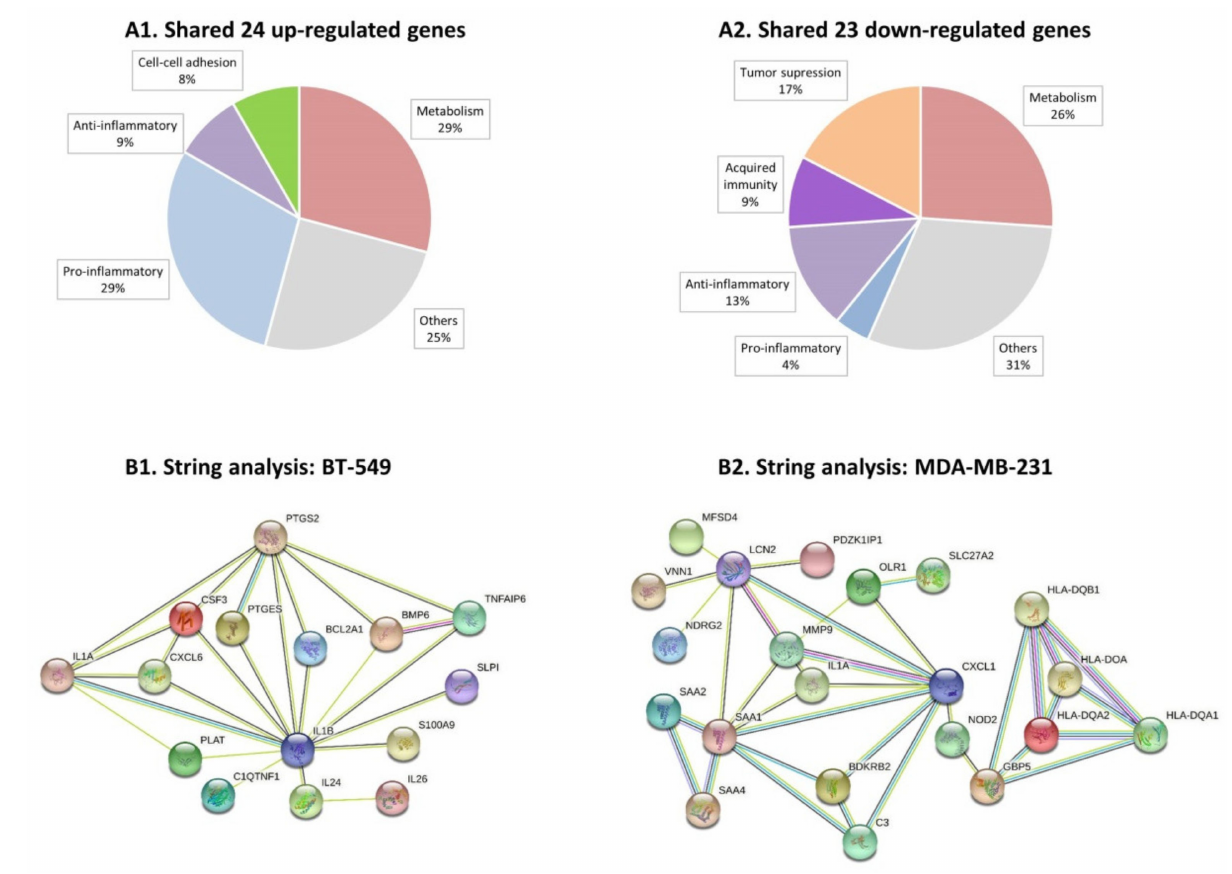
Figure 3. Continuous TNF α + IL-1 β stimulation skews TNBC cells towards a proinflammatory phenotype. BT-549 and MDA-MB-231 cells that were continuously stimulated by TNF α + IL-1 β , or treated by a vehicle control (as described in Figure 1) were subjected to RNAseq analysis (as described in Figure 2). ( A ) This part of the figure describes the categories to which differentially expressed genes—shared between BT-549 and MDA-MB-231 cells—may belong (differentially expressed: between cytokine-stimulated and vehicle control cells). ( A1 ) 24 shared upregulated genes. ( A2 ) 23 shared downregulated genes. The shared genes are indicated in Table S4A (shared upregulated genes) and Table S4B (shared downregulated genes). ( B ) Protein-protein association network analysis (STRING). Top 30 upregulated genes that passed the cutoff FC ≥ 2 or FC ≤ − 2 with pFDR < 0.05 (Table S5) were analyzed in STRING. Color codes are provided herein: https://string-db.org/cgi/input?sessionId=bpw2uCSzWy2E&input_page_active_form=multiple_identifiers [31]. ( B1 ) BT- Table S5B: MDA-Mb-231 cells). The names of 30 top downregulated genes are provided in Table S6 (Table S6A: BT-549 cells; Table S6B: MDA-MB-231